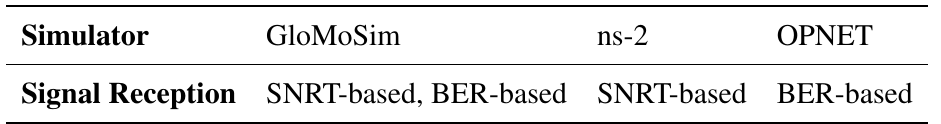
Table 1. Signal reception models in network simulators [24]. SNRT, signal-to-noise ratio threshold; BER, bit error